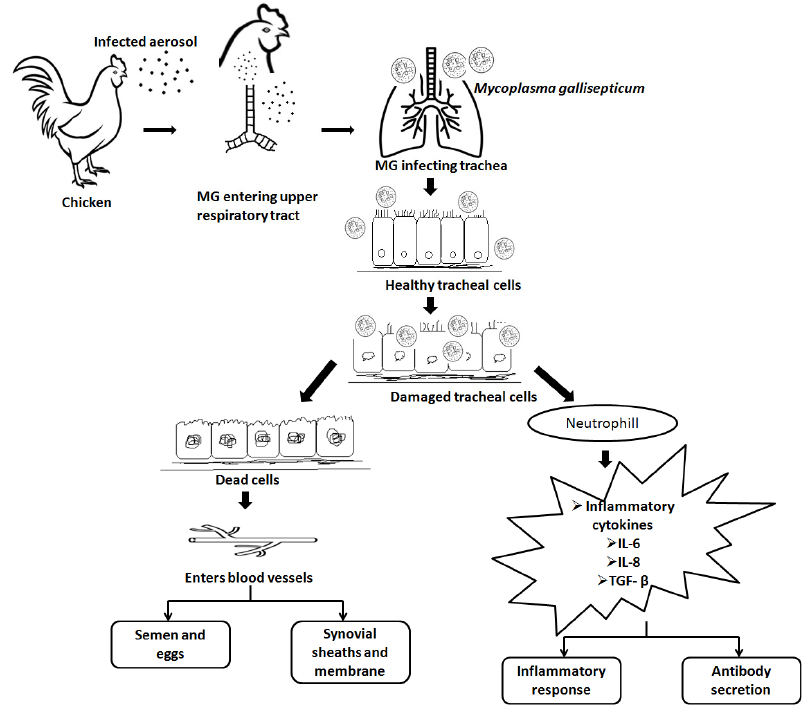
Figure 3. Pathogenesis of M. gallisepticum . M. gallisepticum enters airways; invades healthy cells; damages healthy cells; systemic invasion, immuno-suppression, health, and production loss.